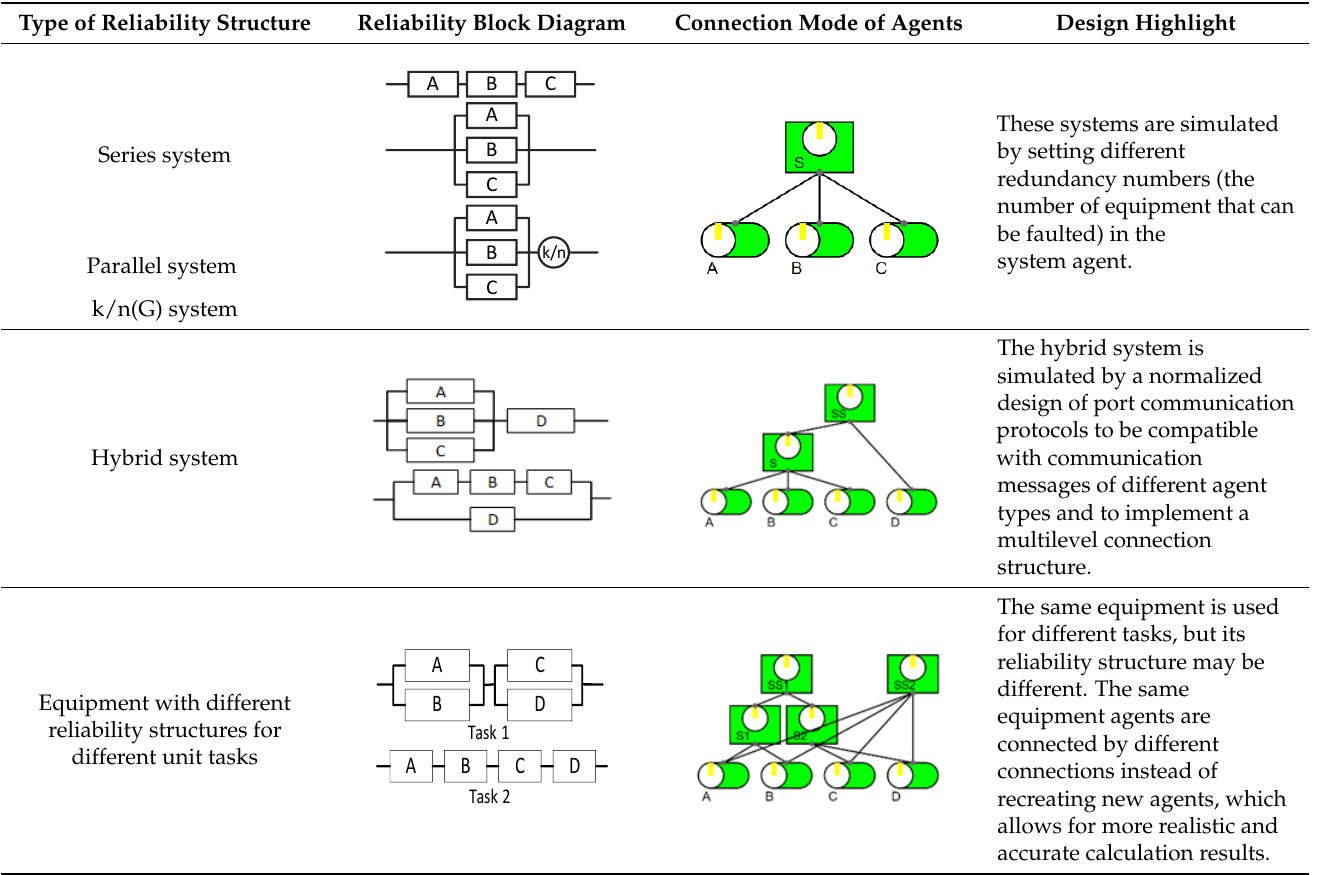
Figure 6. The icon for equipment agent.